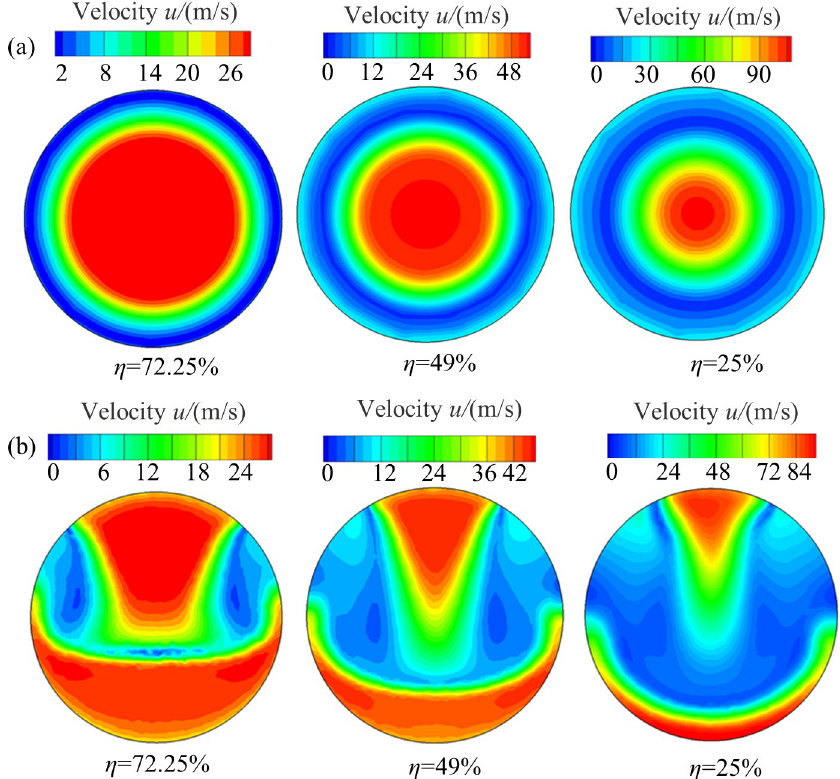
Fig 12. Velocity contours of y - z cross-section at different valve openings ( x = 0.1 m). (a) Air-ring flow regulating valve. (b) Center butterfly valve.